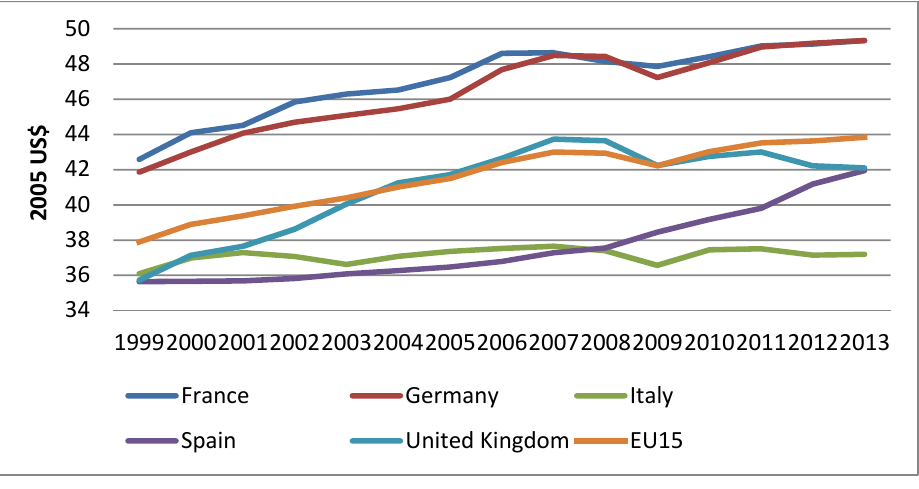
Source: own ellaboration from OECD